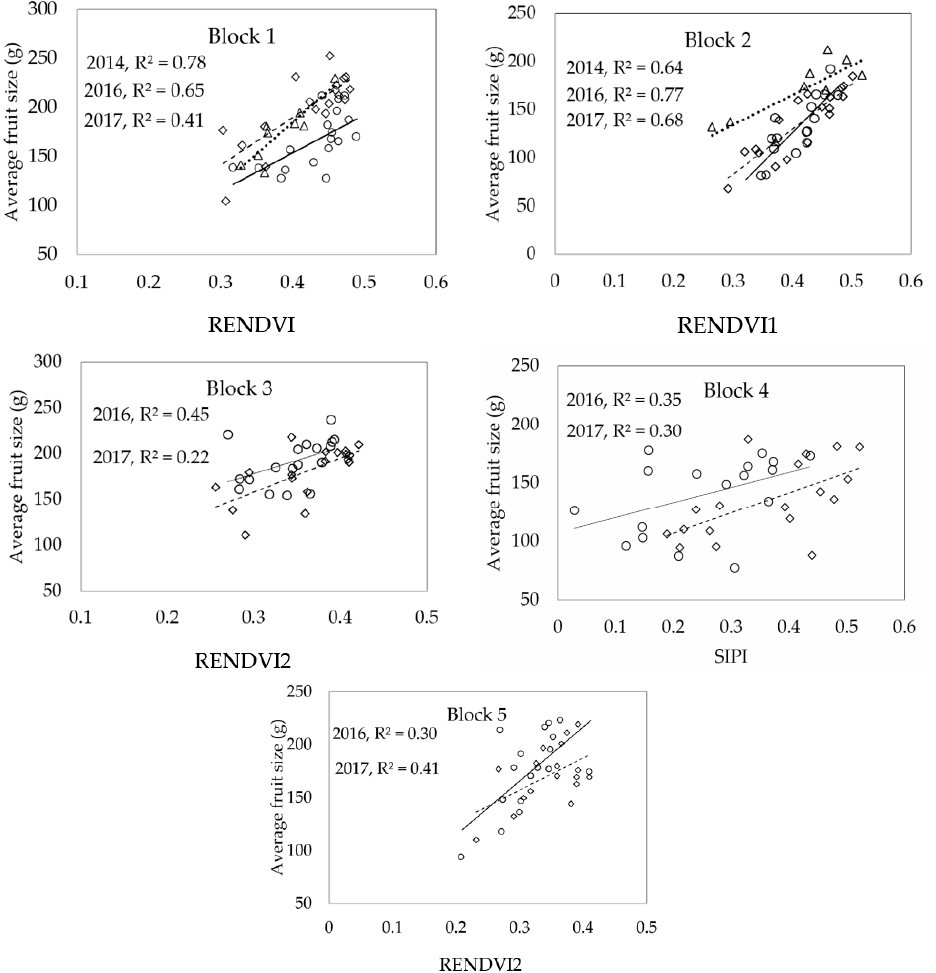
Figure 6. Scatter plot between those VIs identified to have the highest coefficient of determination to average fruit weight per tree (g) for each sampled block derived from WV2 and WV3 imagery. The 2014 sample points are presented as a triangle ( ∆ ) (n = 9 per block) in blocks 1 and 2, with 2016 as a diamond ( ♦ ) (n = 18 per block) and 2017 as circle (o) (n = 18 per block). The results of stepwise regression and ANCOVA for average fruit size (g) per tree in all five blocks are shown in Table 3. No significant differences were observed in slopes for any of the three years data for all five blocks, with the lowest p -value = 0.07 for Block 2. However, the intercepts again differed for all blocks except block 5 ( F -value = 0.67 and p -value = 0.42). This results show the years. Table 3. The stepwise regression and Analysis of covariance (ANCOVA) results for average fruit size (g) per tree for Block 1 and 2 in three years period and Block 3, 4, and 5 in two years period. Slopes Blocks Blocks